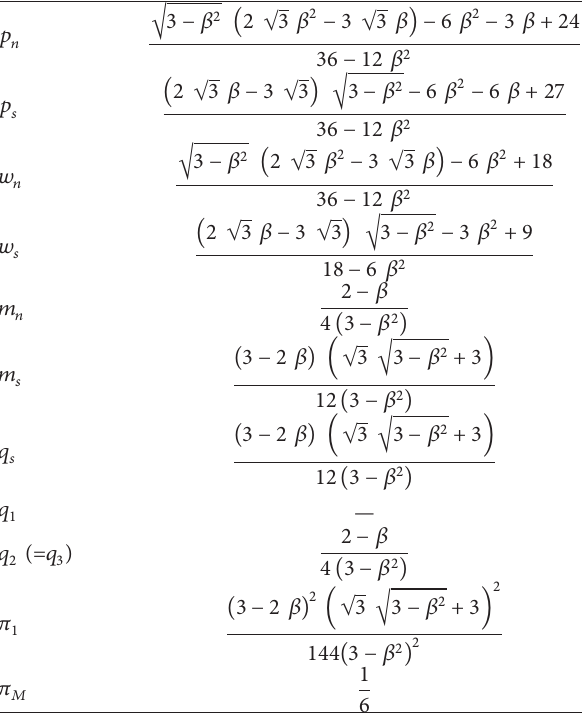
Table 8: Equilibrium outcome under AMR scenario with assort- ment